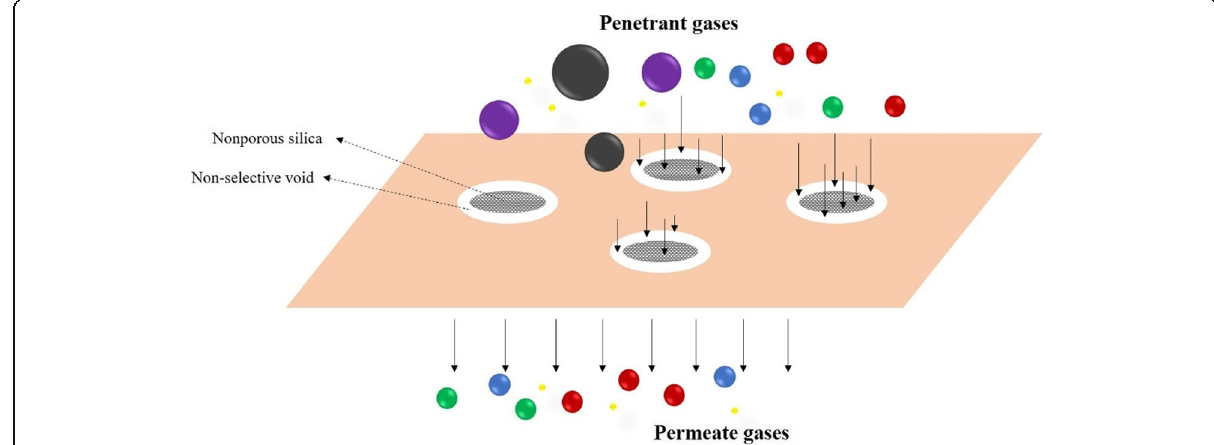
Fig. 7 Gas transport mechanism of penetrant gases through MMMs containing microporous silica with non-selective voids